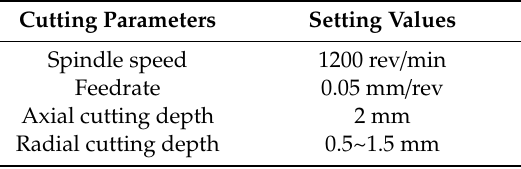
Table 1. Cutting parameters in milling experiment.